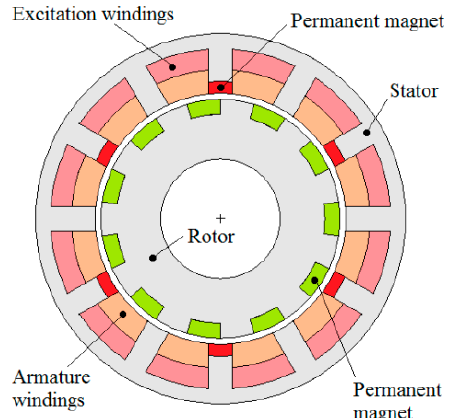
Figure 5. Hybrid excited dual-permanent-magnet (PM) machine [37].